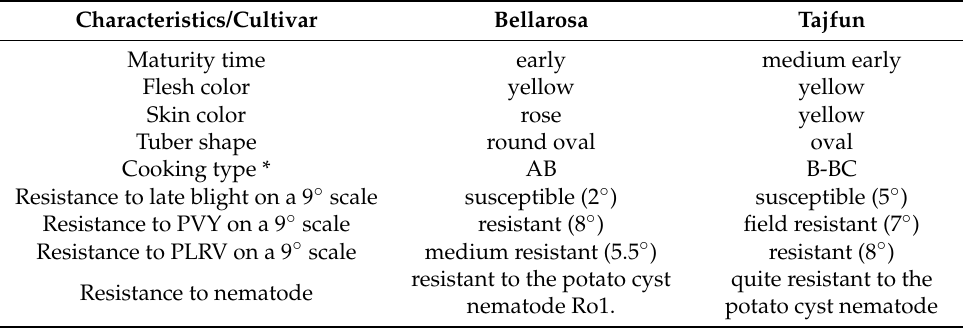
Table 2. A description of potato